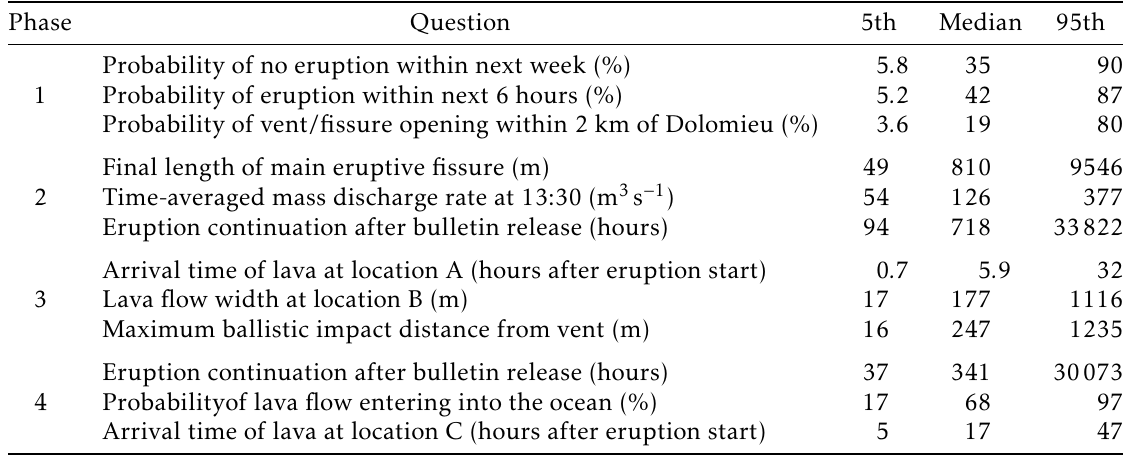
Table A2: Percentile values for the probability density functions of the EW of Figure 7. In contrast to Figure 7, values of questions 1 and 3 from Phase 2 and question 1 from Phase 4 have been reported here on a linear scale.